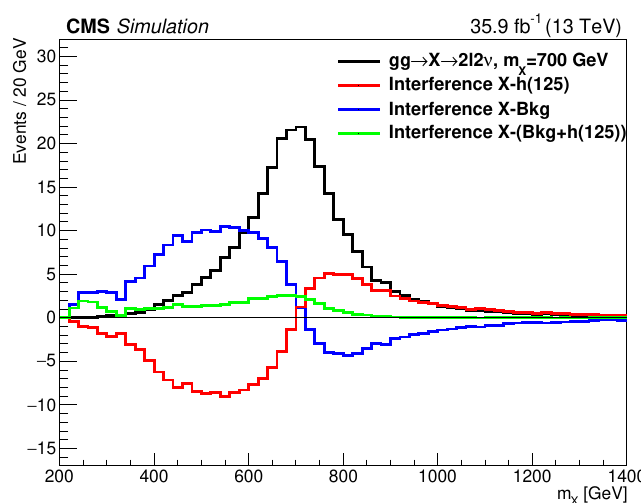
Figure 1 . Generator-level mass of a ggF-produced 700 GeV signal (black line) normalized to the SM cross section and without considering interference e(cid:11)ects. The e(cid:11)ects of the interference of the signal with the gg ! WW continuum and the gg ! h(125) o(cid:11)-shell tail are shown, together with the total interference